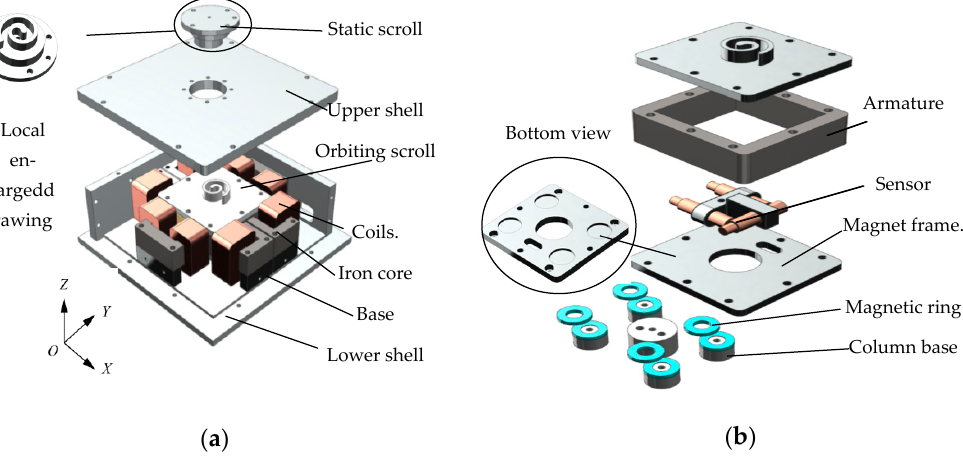
Figure 1. Structure of MDOFSC ( a ) Overall structure; ( b ) Suspension mechanism.